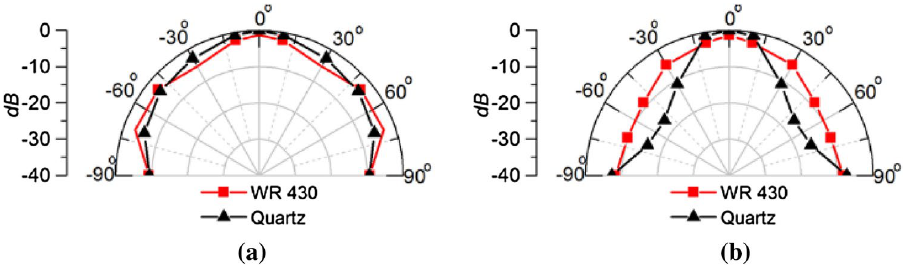
Figure 19. Measured power penetration pattern at a 50 mm radius inside the inhomogeneous phantom for the quartz loaded waveguide and standard WR 430 waveguide at ( a ) E-plane, ( b ) H-plane.